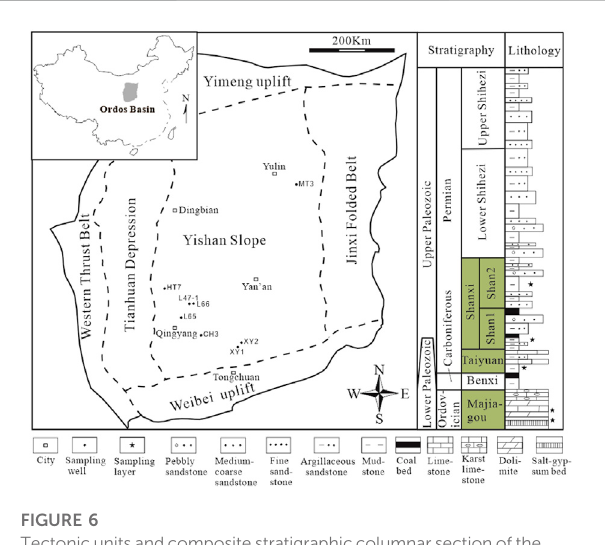
FIGURE 5 Cross-plot of C 20 -C 21 -C 23 tricyclic terpane (TT) ratios with two de fi ned end-member domains of plankton and terrigenous plants. Almost all C 20 -C 21 -C 23 TT data in this study fall into a range from the terrigenous plants domain to the plankton domain.